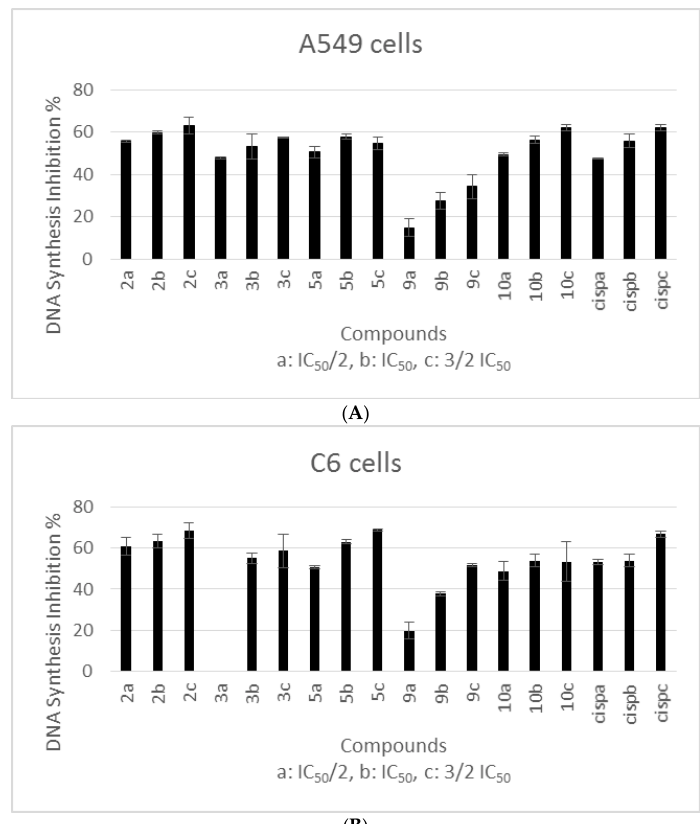
Figure 1. DNA Synthesis inhibitory effects of compounds 2 , 3 , 5 , 9 , 10 and cisplatin on A549 ( A ) and C6 ( B ) cells. Mean percent absorbance of untreated control cells were assumed 0%. Three different concentrations (a: IC 50 /2, b: IC 50 , c: 3/2 IC 50 ) of test compounds and cisplatin were given. Data points represent means for two independent experiments ± SD of four independent wells. p <